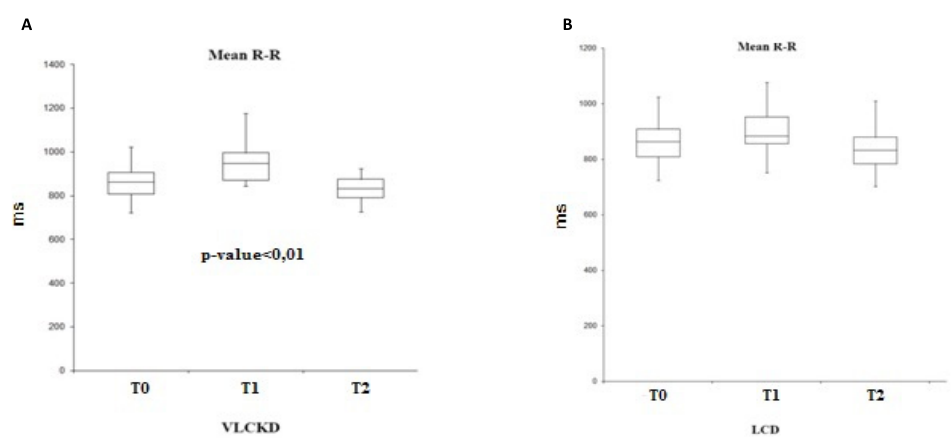
Figure 3. Variability of the mean R-R in VLCKD subjects ( A ) and in LCD subjects ( B ). Figure 3 . Variability of the mean R-R in VLCKD subjects (A) and in LCD subjects (B).